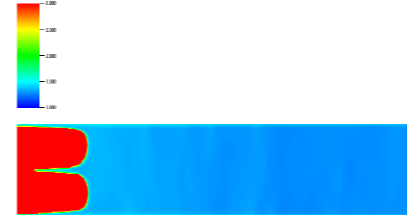
Figure 3 Temperature distribution ahead of the flame If increasing the concentration of hydrogen to 28.5%